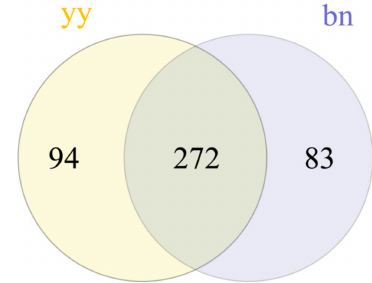
Figure 3. The Venn diagram showing the similarities and di ff erences in DEMs between vegetative cells (yy) and dormant cysts (bn) of P. cristata